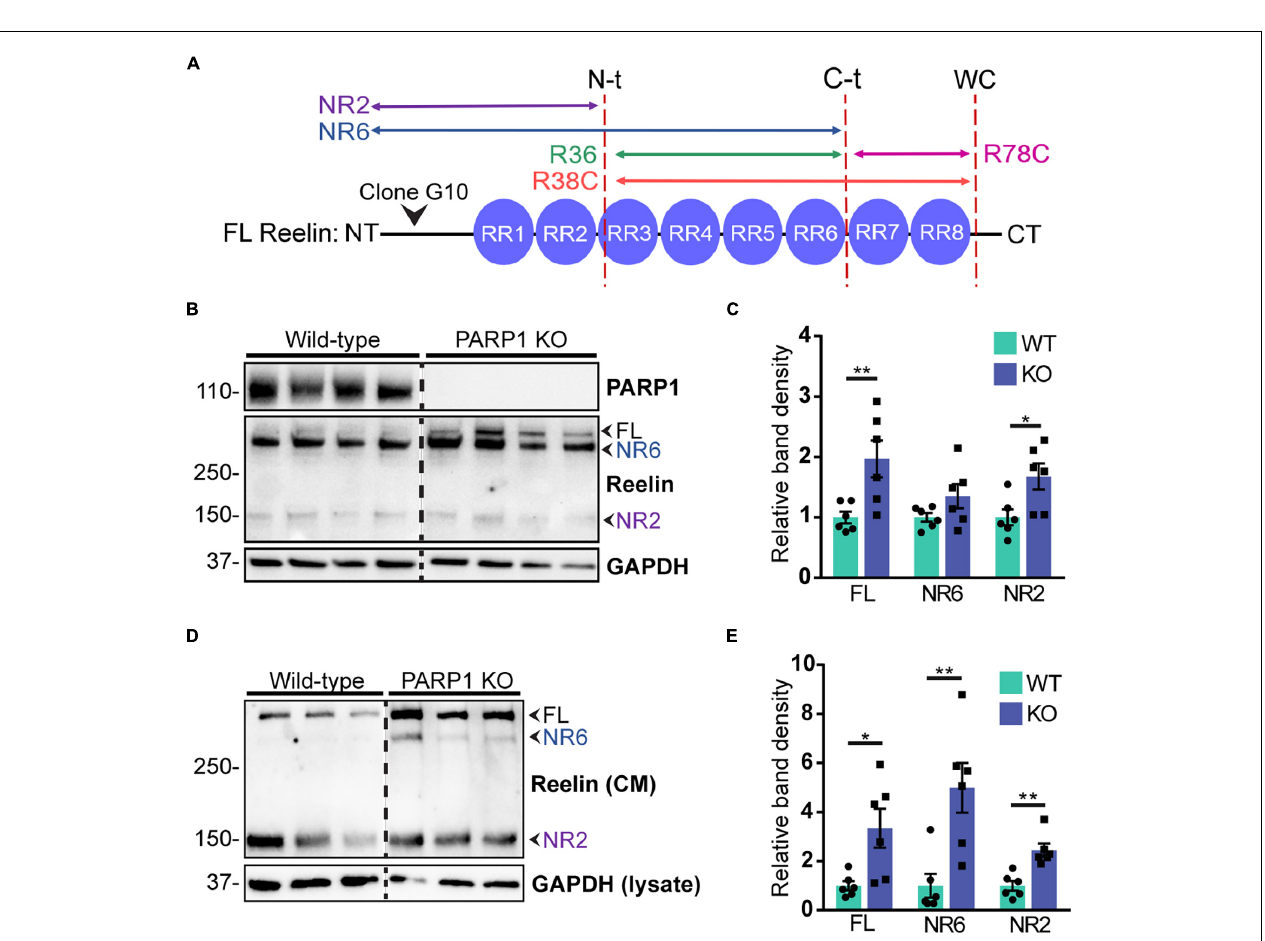
FIGURE 8 | Poly (ADP-ribose) polymerase 1 KO NPC cultures overexpress Reelin protein. (A) Schematic drawing of Reelin depicting its proteolytic cleavage sites (vertical dotted lines) and the site of recognition for the N-t clone G10 Reelin antibody. This antibody recognizes full-length (FL) Reelin as well as the NR6 and NR2 Reelin fragments. (B) Reelin western blot from WT and PARP1 KO NPC lysates shows increased Reelin protein in KO NPC cultures. Arrows indicate the FL, NR2, and NR6 fragments. (C) Quantification of relative band density of FL Reelin, the NR2 fragment, and the NR6 fragment normalized to GAPDH ( n = 6). NR6: p = 0.24; * p = 0.026; ** p = 0.0087 by Mann–Whitney test. (D) Western blot for Reelin in conditioned media (CM) and GAPDH in cell lysates of WT and KO NPCs. (E) Quantification of band densities of FL Reelin, NR2, and NR6 fragments normalized to GAPDH in cell lysates ( n = 6 separate cultures) indicate increased Reelin present in media conditioned by KO NPC cultures. * p < 0.05; ** p < 0.01 by Mann–Whitney